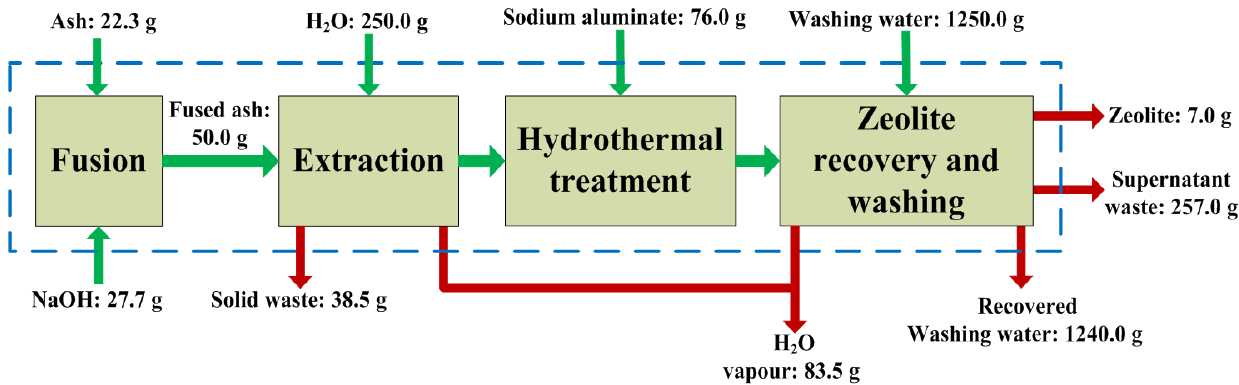
Figure 4. Block flow diagram illustrating the overall mass balance of the fusion assisted